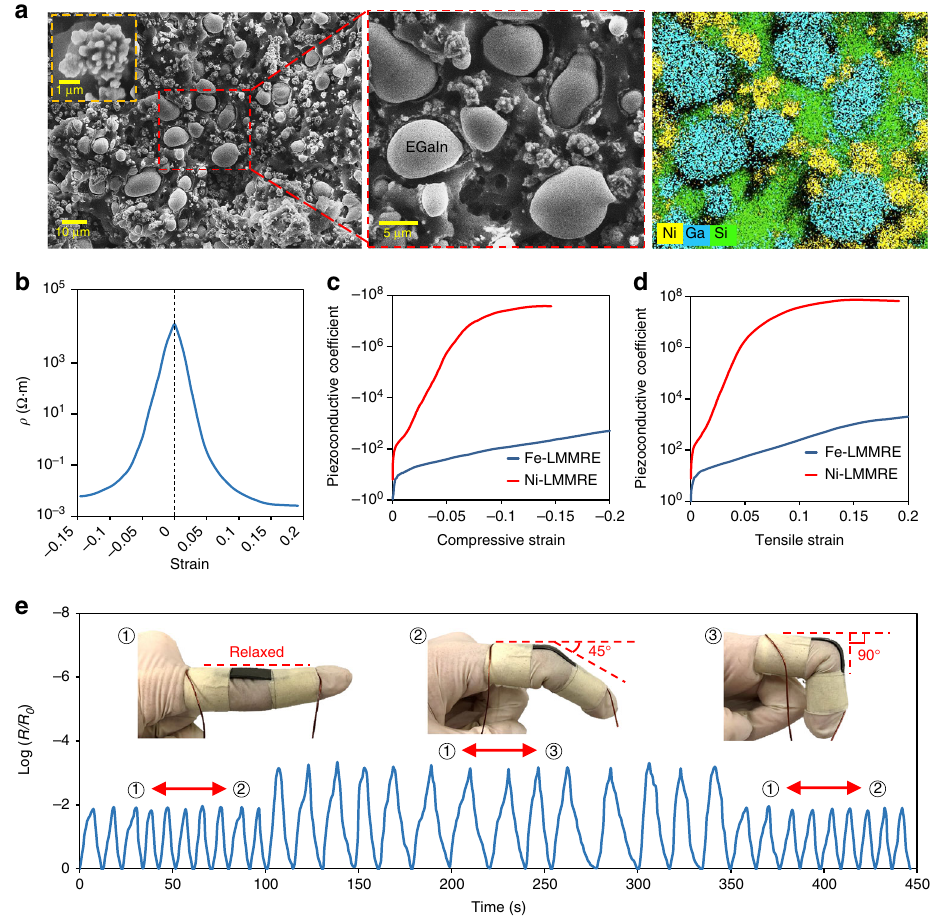
Fig. 3 Investigating the properties of the nickel (Ni)-liquid metal- fi lled magnetorheological elastomer (LMMRE). a Scanning electron microscopy (SEM) images and the energy dispersive X-ray spectroscopy (EDS) mapping of the Ni-LMMRE (LMMRE using Ni microparticles). b Resistivity-strain curve of the Ni-LMMRE under compression and stretching. c , d Piezoconductive coef fi cient-strain curve of the iron (Fe)- and Ni-LMMRE under compression and stretching. e Resistance changes of the composite under cyclic bending. The strip sample was attached to the index fi